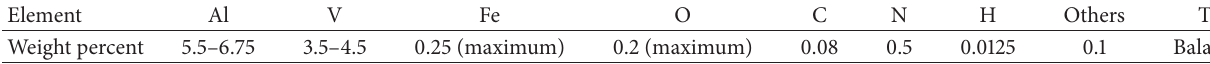
Table 1: Chemical composition of Ti-6Al-4V in weight percent.